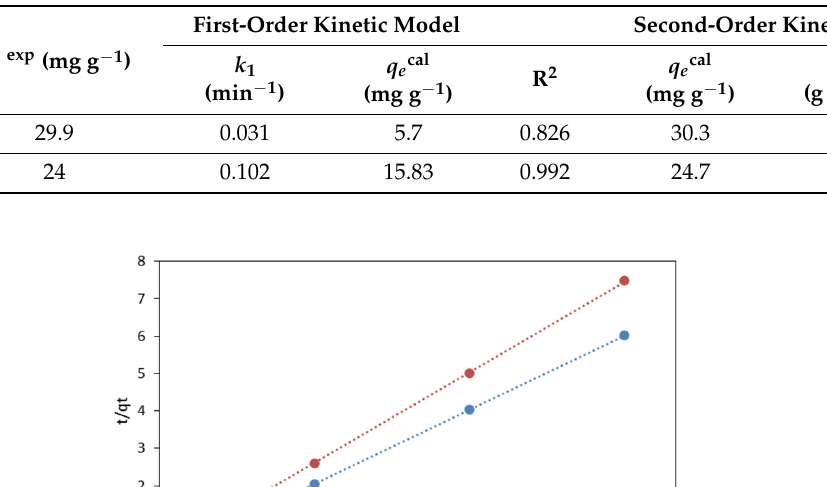
Table 2. Comparison of the first- and the second-order kinetic models for Zn 2+ adsorption.